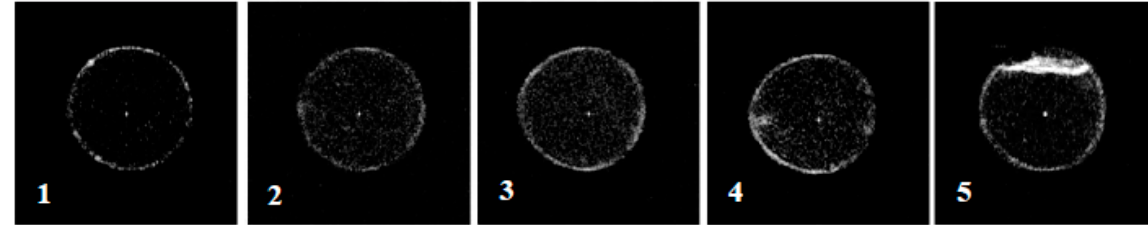
Figure 14. Pore images of half ‐ saturated rock samples.